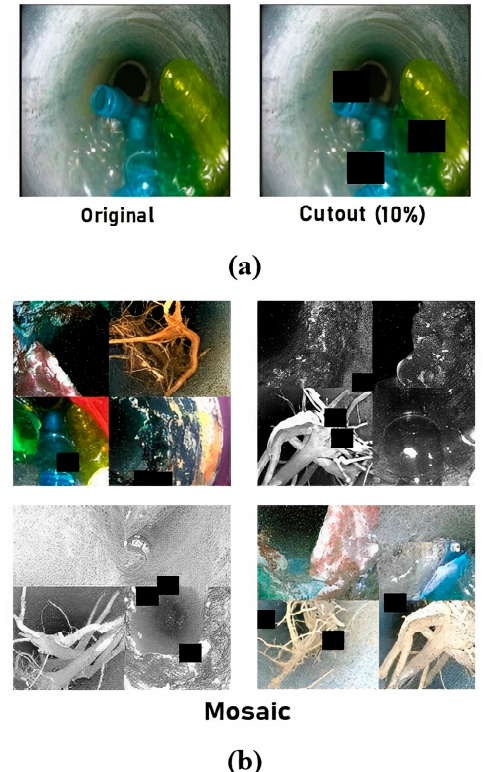
Figure 13. Visual upshots of advanced augmentation techniques: ( a ) cutout and ( b ) mosaic. Augmentation techniques facilitate enhancing the efficiency of the object detection model by increasing the number and variegation of learning instances and related anno- tations. These techniques also reduce training time and costs for search detection models.